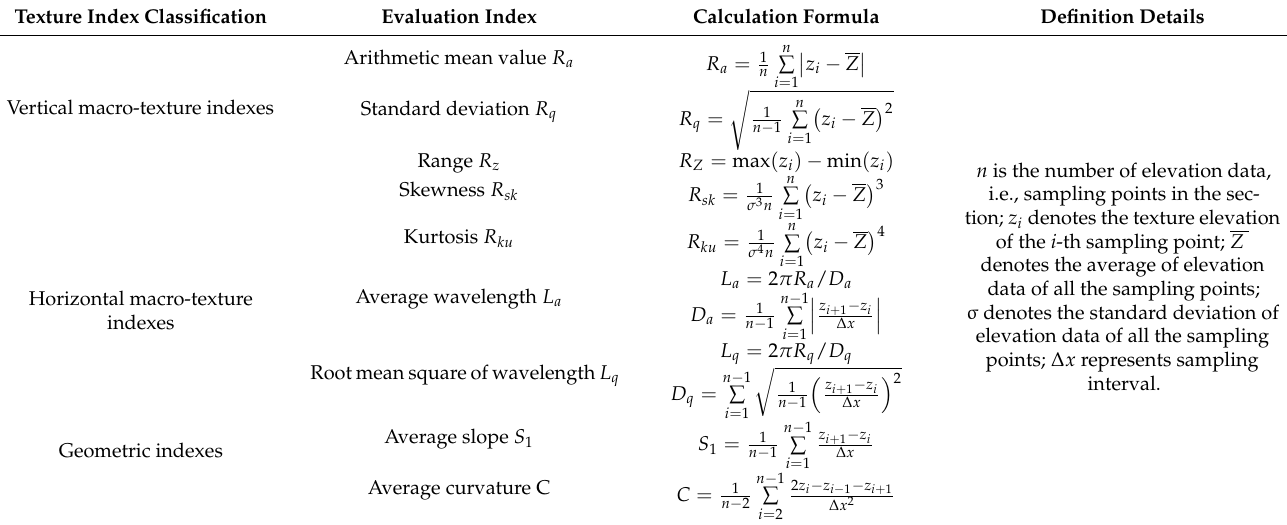
Table 3. All the evaluation indexes of pavement surface macro-texture involved in this